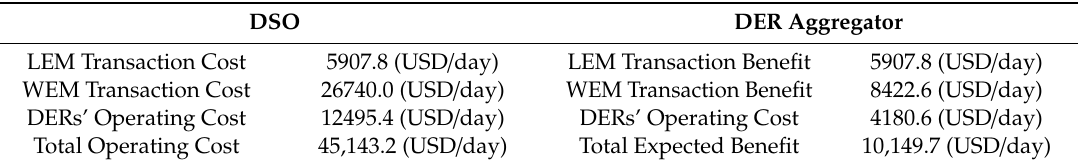
Table 9. Cost and benefit distribution of market participants considering the competitive environment. DSO DER